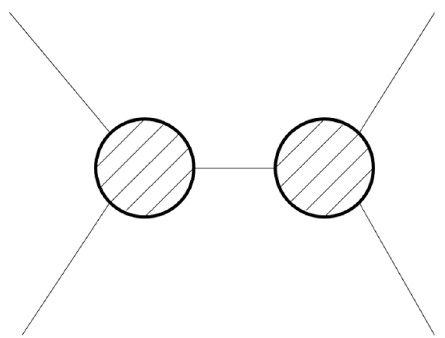
Figure 2. Exchange diagram. Circles represent non-perturbative, exact 3-particle